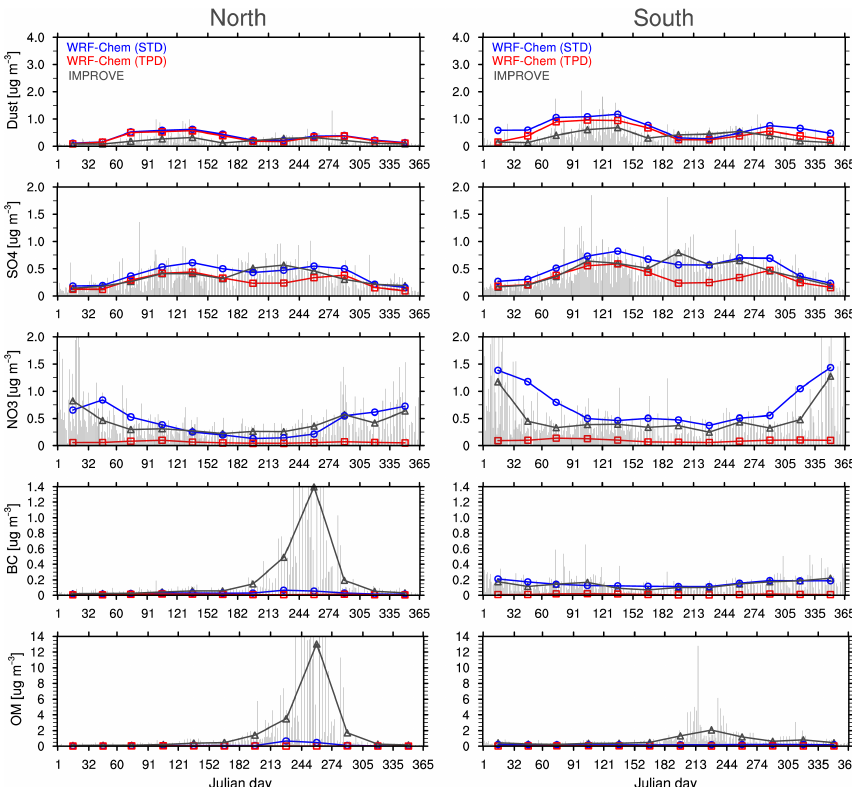
Figure 15. Daily mass concentrations of fine-mode (PM 2 . 5 ) dust, sulfate, nitrate, BC, and OM averaged for the period 2010–2014 at the IMPROVE sites over the northwestern and southwestern USA (shown in Fig. 1) from the IMPROVE observation (vertical gray bars) and the monthly average of the IMPROVE observation (gray triangles) and the corresponding WRF-Chem standard simulation (STD; blue dots) and the sensitivity simulation without North American emissions (TPD; red